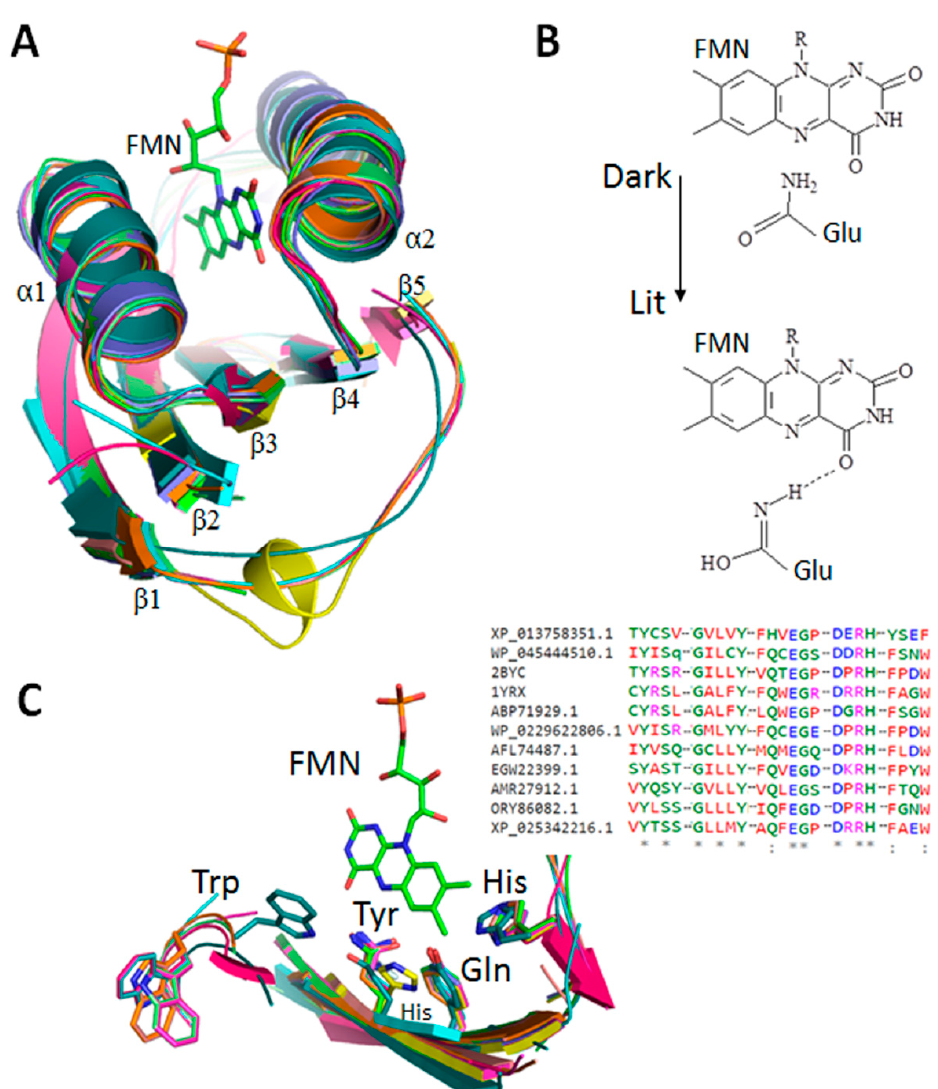
Figure 4. Models of the BLUF domains and details of its flavin binding pocket. ( A ) Superposition of the modelled BLUF domains using the Phyre server with a crystal structure of Rhodobacter sphaeroides BlrB (PDB: 2BYC) (magenta). The homology models include the annotated BLUF domains from WP_045444510.1 ( Psychrobacter sp. ) (Green tone); WP_014148160.1 ( Methylomicrobium alcaliphilum ) (Brown tone); XP_025342216.1 ( Pseudomicrostroma glucosiphilum ) (Blue tone); AFL74487.1 ( Thiocystis violascens ) (Violet tone); EHQ08139.1 ( Leptonema illini ) (Yellow tone); ABP71929.1 Rhodobacter sphaeroides ATCC 17025 (Pink tone); WP_0229622806.1 ( Pseudomonas pelagia ) (Skyblue tone); and ORY86082.1 ( Protomyces inouyei ) (Smudge tone). The domain boundaries of the modelled BLUFs are mentioned in Table 1. ( B ) The BLUF photocycle scheme shows the protein/FAD interactions through the hydrogen bonding pattern of the flavin moiety with conserved glutamine upon illumination. ( C ) Superposition of the flavin binding pocket in the BLUF models in comparison to Rhodobacter sphaeroides BlrB (PDB: 2BYC) and the BLUF domain of AppA (PDB: 1YRX). The side chains of residues with potentially important roles in catalysis and/or substrate binding are shown as stick models and are labelled. The selected regions of the same are shown in a reduced multiple sequence